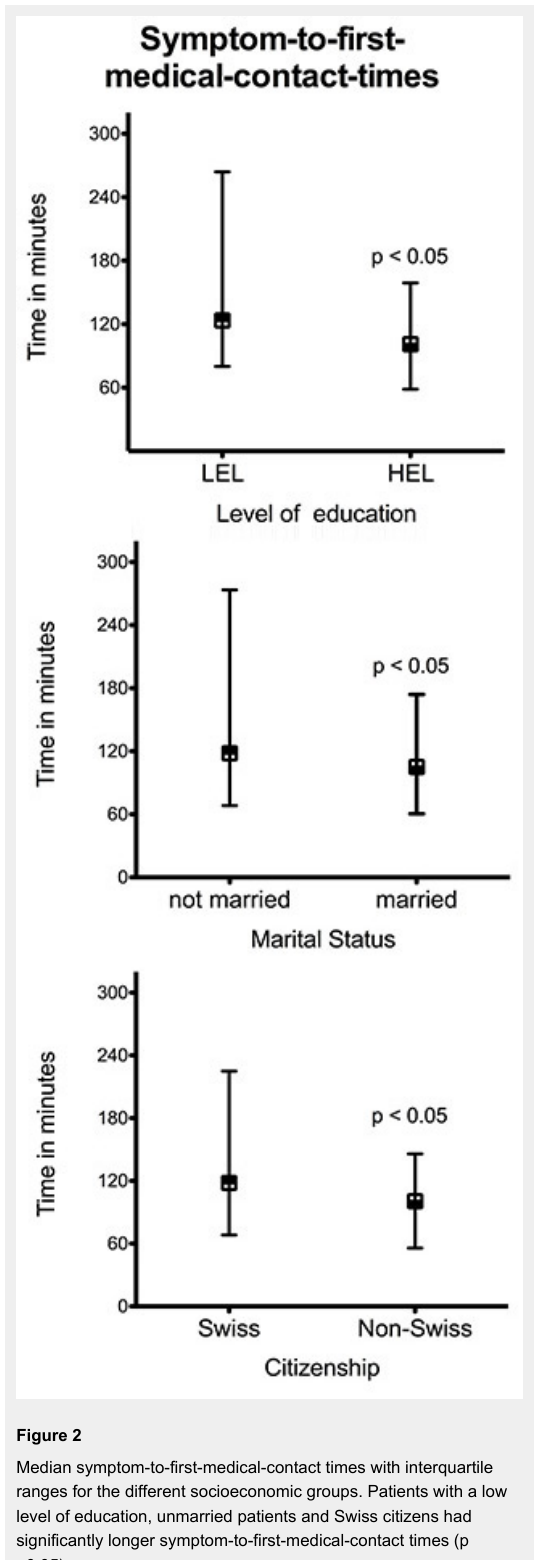
Median symptom-to-first-medical-contact times with interquartile ranges for the different socioeconomic groups. Patients with a low level of education, unmarried patients and Swiss citizens had significantly longer symptom-to-first-medical-contact times (p